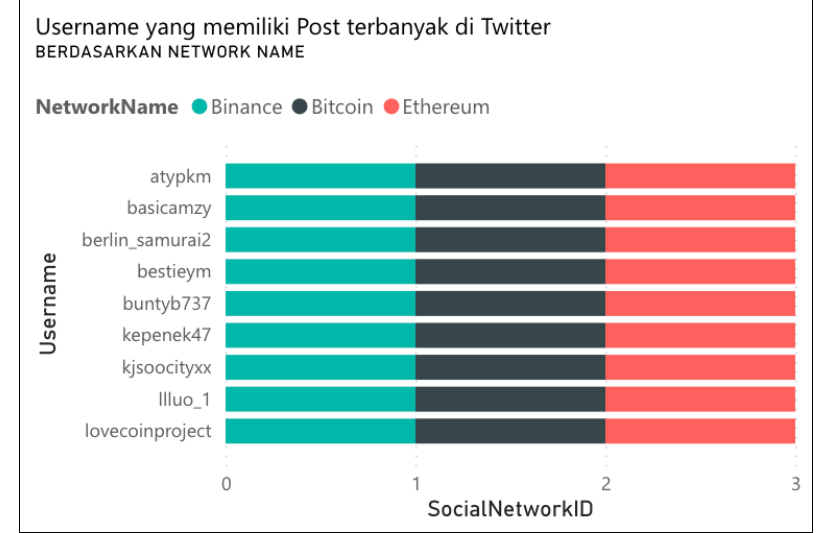
Figure 5(e). Most post by Actors in Twitter